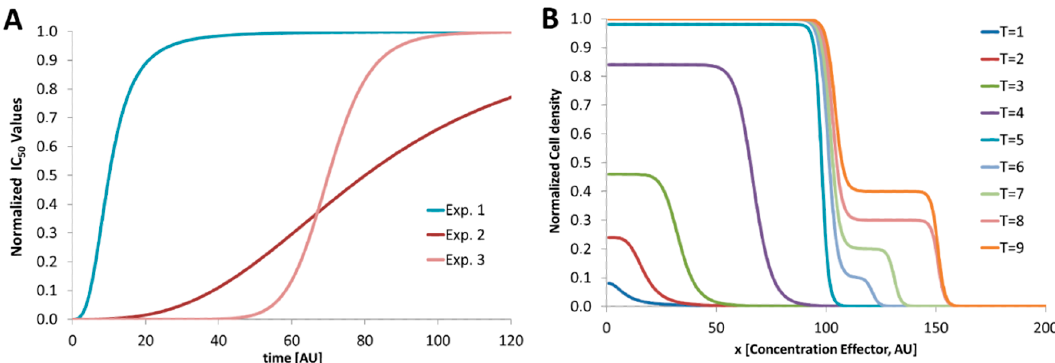
Figure 2. Schematic graphs. ( A ) Schematic development of IC50 values with respect to the varying response behavior to different experimental conditions such as different organisms, effectors or broth media; ( B ) nonlinear behavior of an organism which responds to the effector differently. After prolonged incubation (T > 5) a second growth phase takes place at higher effector concentrations (>100) and moves the IC50 value from about 100 to about 150 (AU).